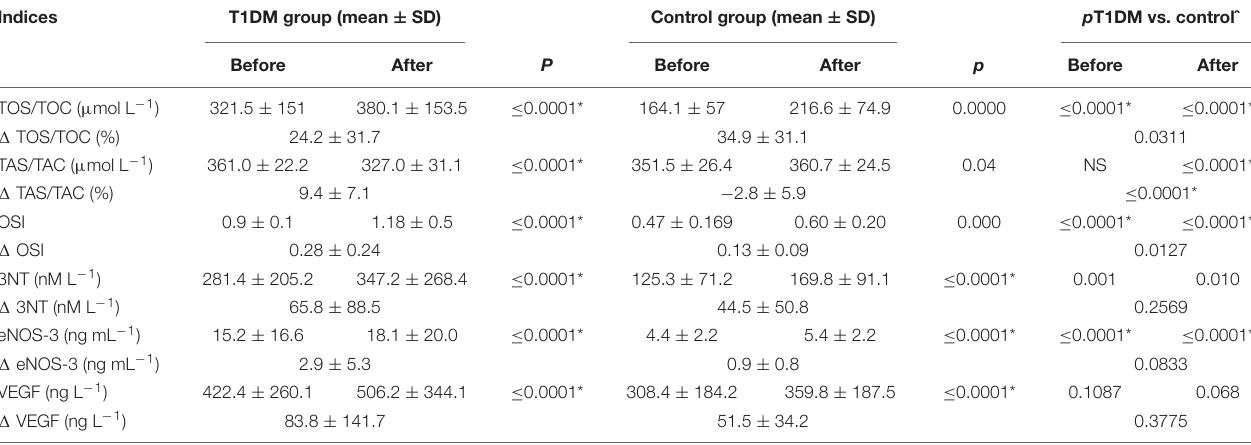
TABLE 5 | Oxidative and nitrosative stress and endothelial function indicators before and after maximum-intensity exercise. Indices T1DM group (mean ± SD) Control group (mean ± SD) p T1DM vs. controlˆ Before After P Before After p Before After TOS/TOC ( µ mol L − 1